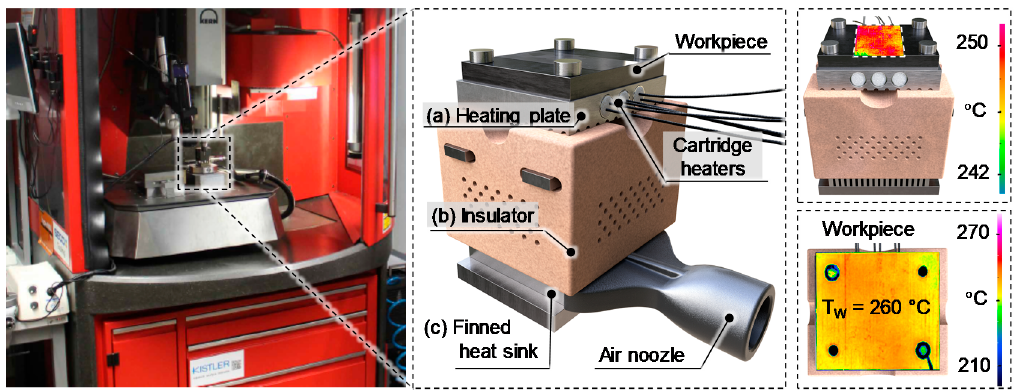
Figure 1. Machine tool KERN HSPC 2522 and the device for heating the workpiece to realise a thermally assisted micromilling process.